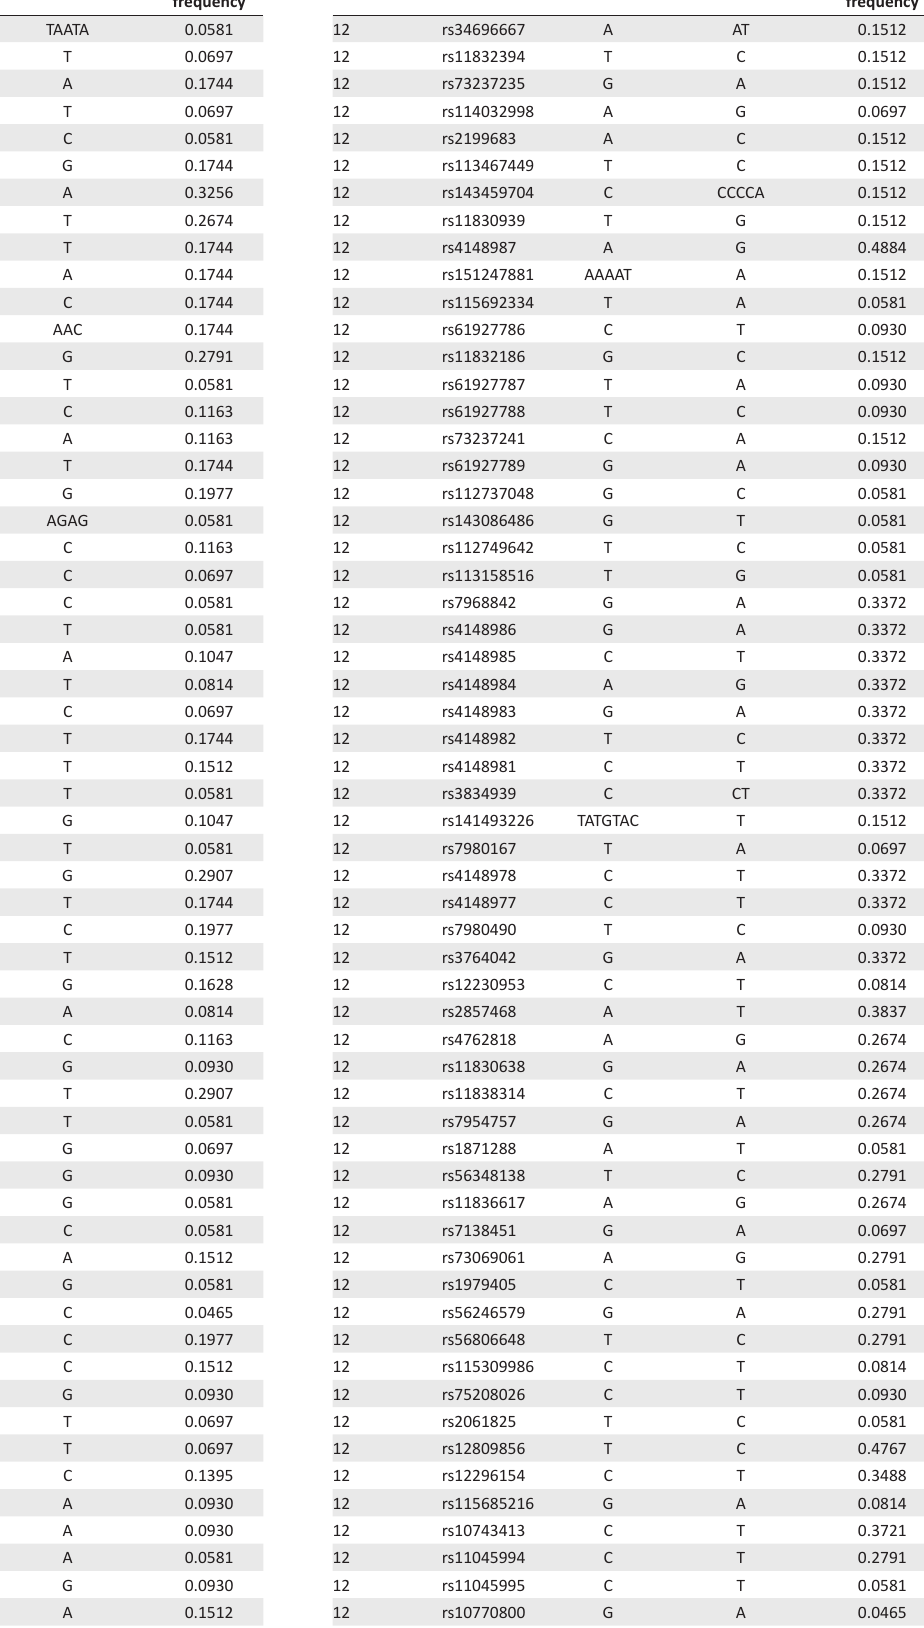
Table 1-A1 (Continues...): Minor allele frequencies for 1846 polymorphisms in 43 black South Africans. Chromosome Polymorphism Minor allele Major allele